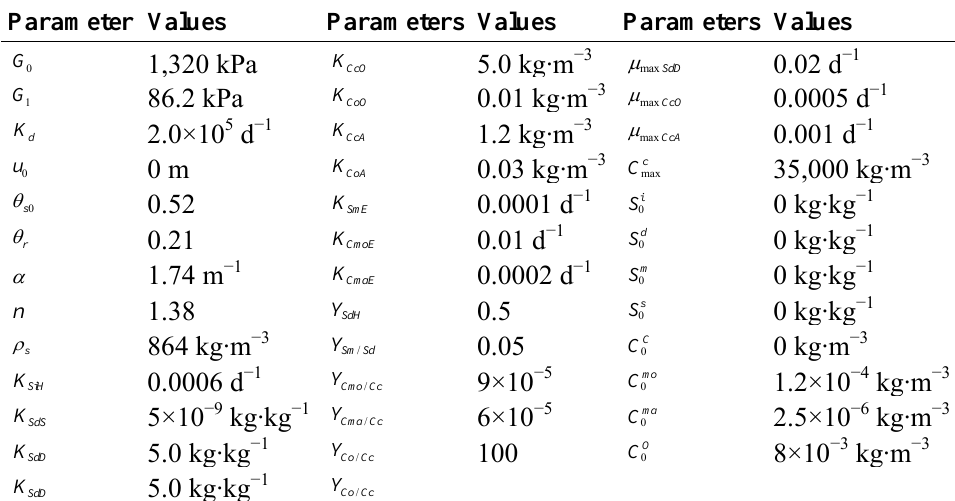
Table 1. Model parameters.